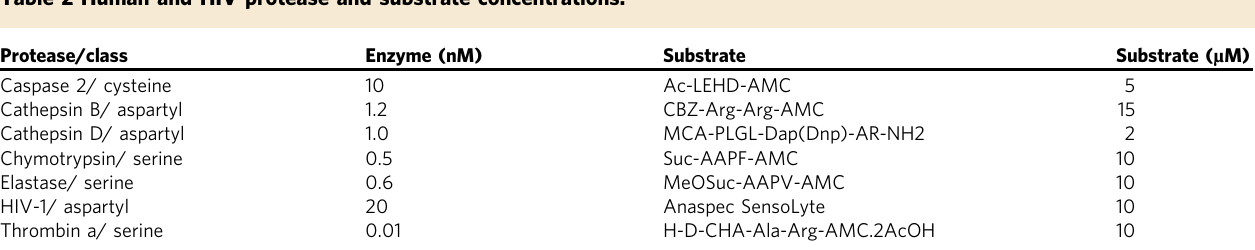
Table 2 Human and HIV protease and substrate